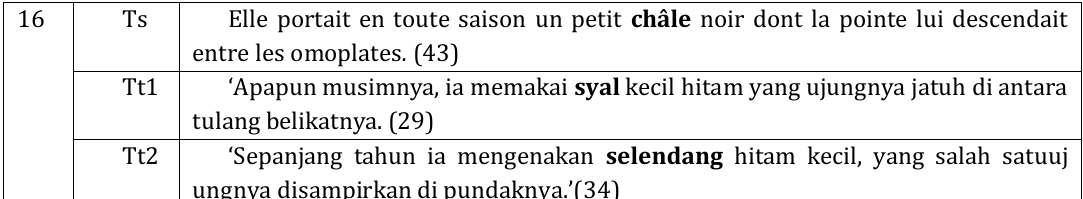
Tableu 16 La technique